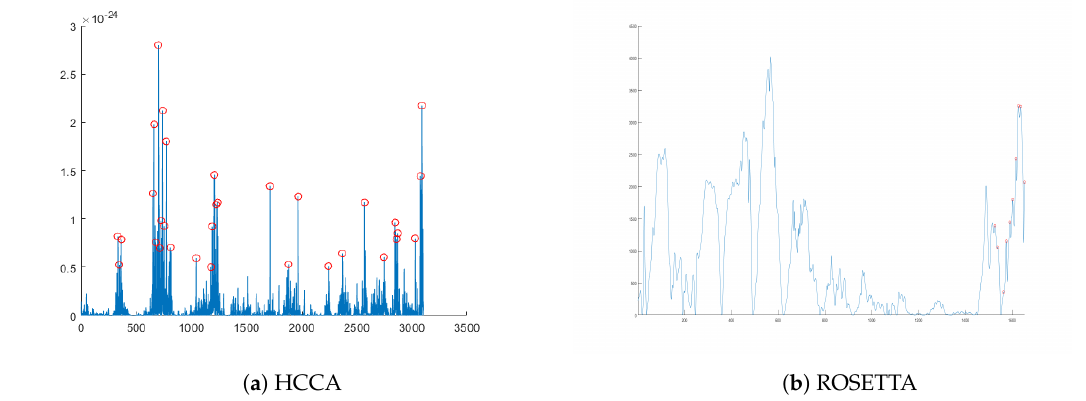
Figure 4. Squared pairwise t-differences (SOST; line) and points of interest (POIs; red circle). ( a ) Points having higher SOST values than the heuristic threshold are chosen for HCCA’s POIs. ( b ) Unlike HCCA, ROSETTA’s POIs, upon which the output value of w -bit multiplication is processed, are chosen